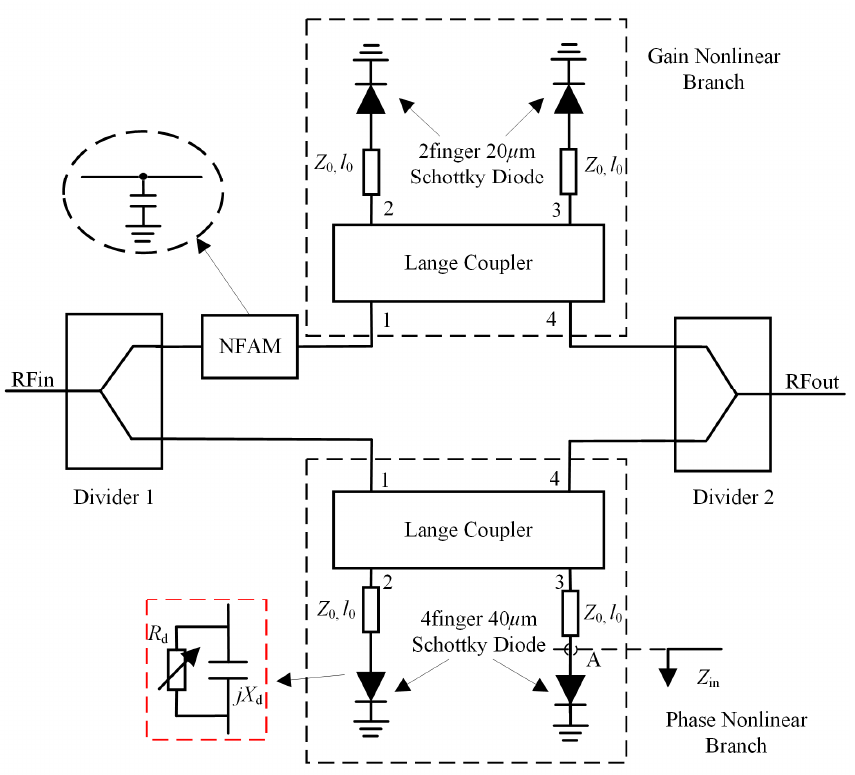
Figure 1. Analog predistortion MMIC schematic.